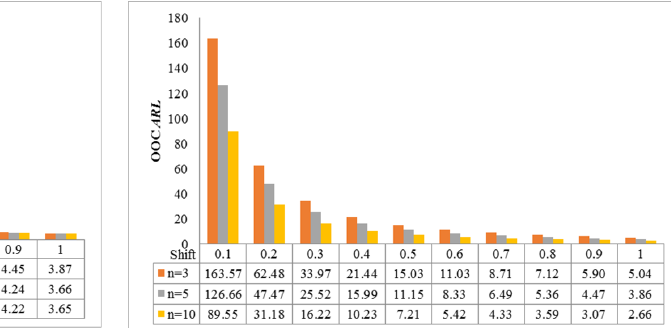
Fig. 2. The 𝐴𝑅𝐿 profiles of the HWMA 𝑋(cid:3364) ∗ scheme (for the mixed-3&4 strategy) with a constant variance when 𝑛 =5, 𝜆 =0.1, 𝜙 =0.75, 𝛾 =0.75, 𝐿 ∗ =2.938 and 𝐴𝑅𝐿 different values of 𝐵